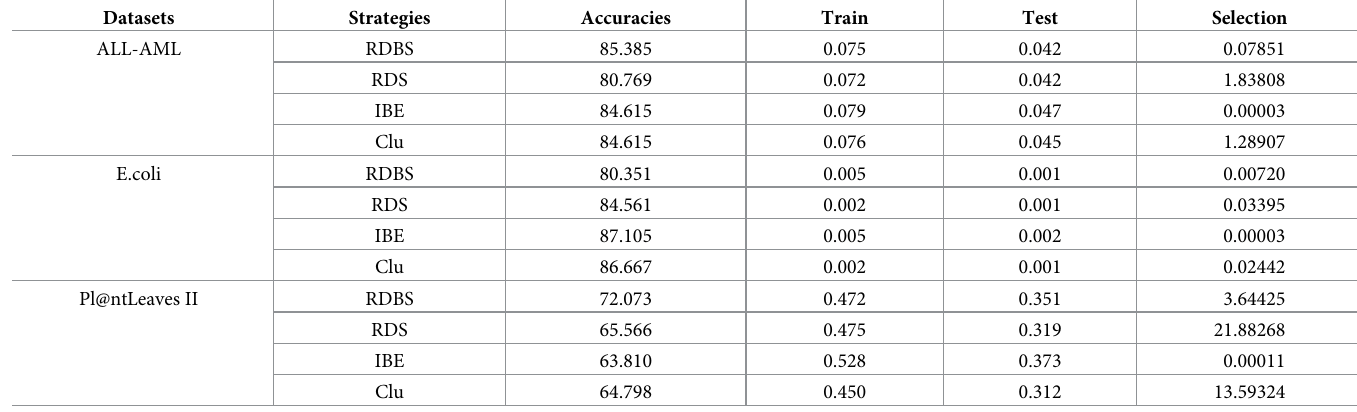
Table 8. Average accuracies and computational times (in milliseconds) for the training, testing and selection processes obtained by each selection strategy in the 3rd iteration, using the YATSI-OPF classifier for all datasets.